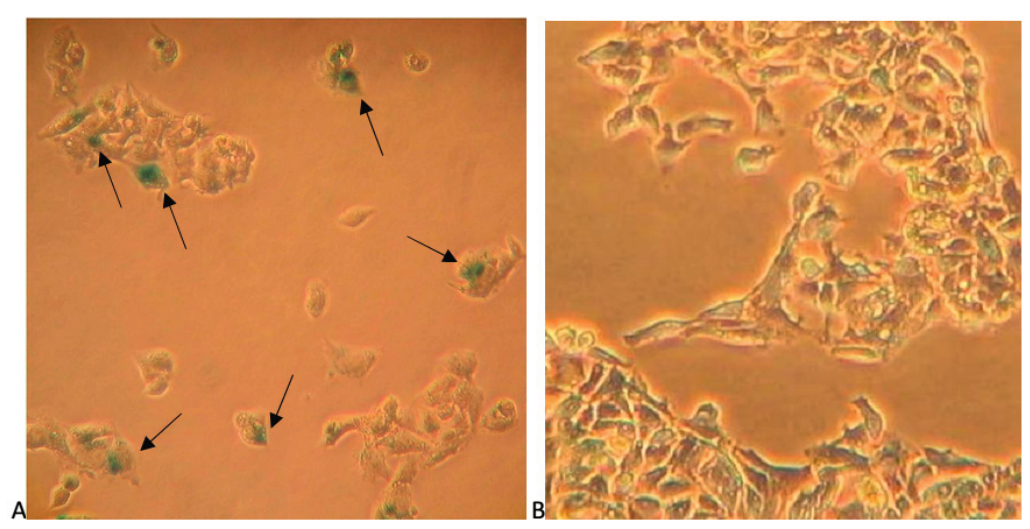
Figure 7. ( a ) β -Galactosidase staining of HepG2 cells treated with 5 µM papaverine for 48 h per passage after 41 days and ( b ) of untreated cells. Positively stained cells are marked by an